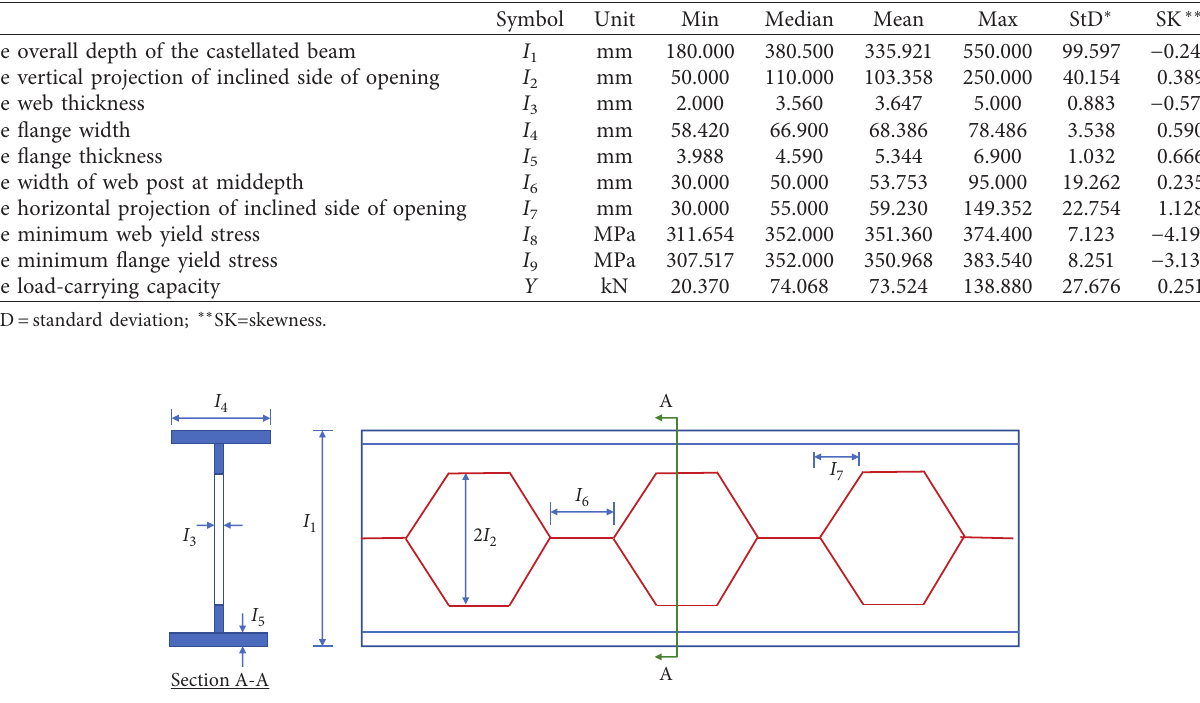
Table 1: Summary of the input and output variables of CSB beams used in this study.